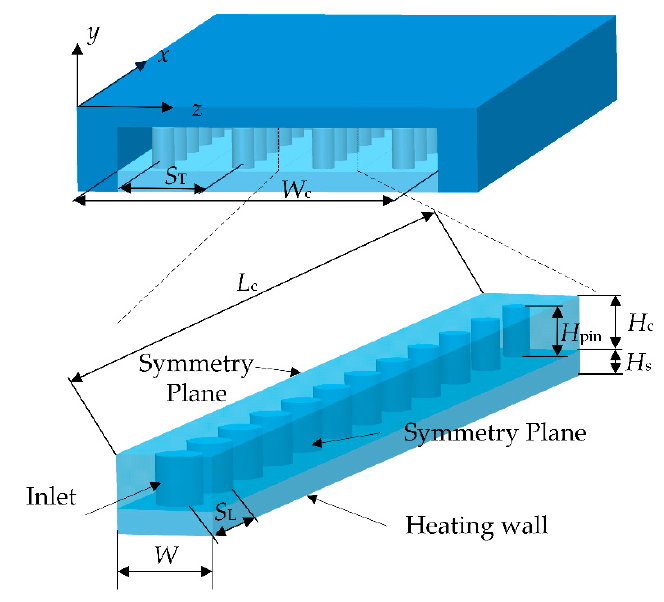
Figure 1. Schematic diagram of the pin-fin array. Table 1. Structural parameters of the non-uniform pin-fin array for hydrogen production. Change Rate of Pin Diameter γ ,